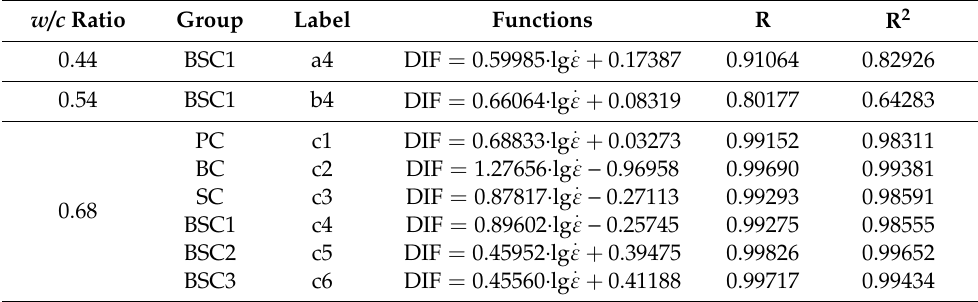
Figure 13. Strain rate effect on DIF of BSFRC: ( a ) w/c ratio: 0.68; ( b ) BSC1. Table 5. The linear fitting results of DIF